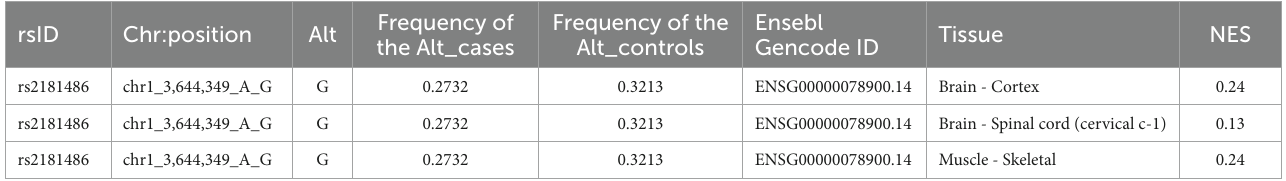
TABLE 3 Effect of the common variant rs2181486 on TP73 protein expression in different regions of normal human brain and skeletal